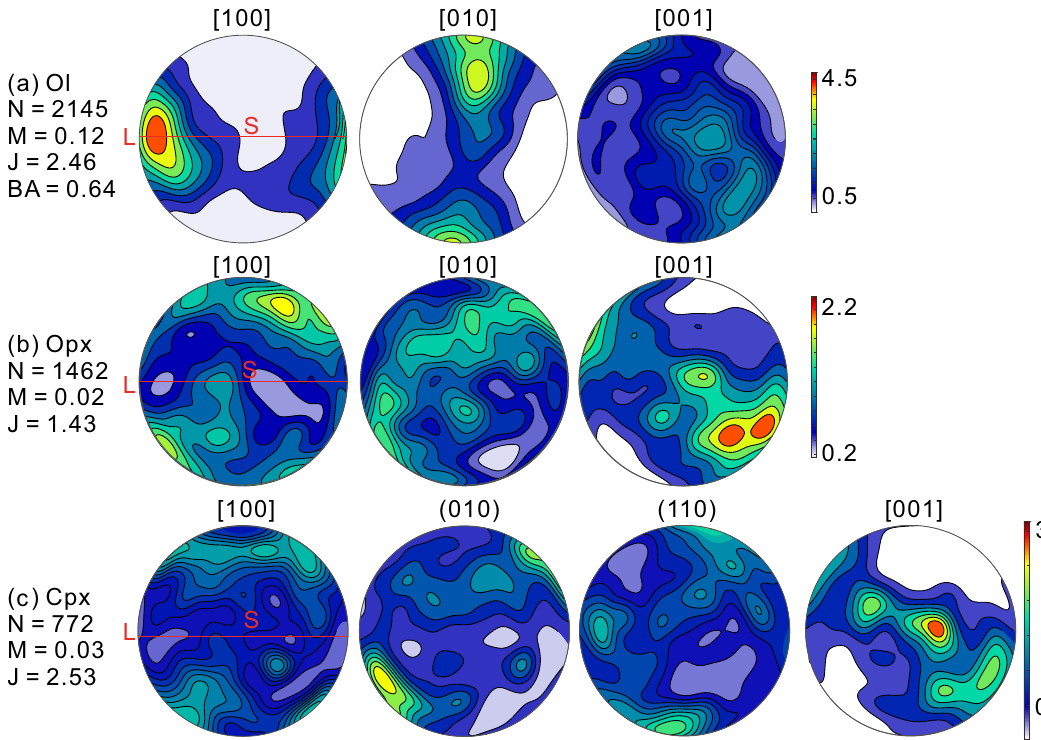
Figure 2. One-point-per-grain crystallographic preferred orientations of ( a ) olivine, ( b ) orthopyroxene and ( c ) clinopyroxene in the studied samples. N: number of grains, M: M-index, J: J-index, and BA: BA-index. L and S are the lineation and foliation,